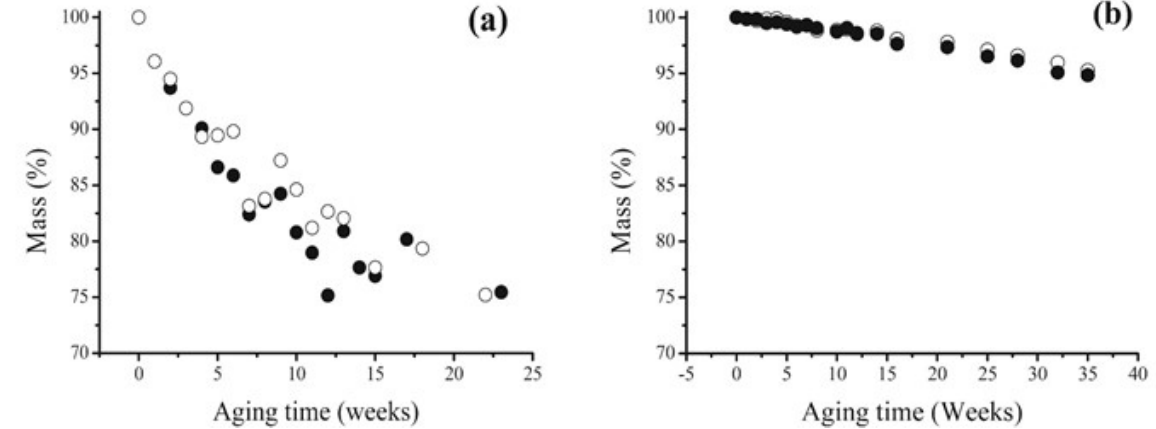
Figure 3. Mass vs. artificial ageing time for as-collected ( ○ ) and cleaned ( ● ) 30-year-old PVC films in open ( a ) and closed ( b ) environments. Image reprinted with permission from [54].